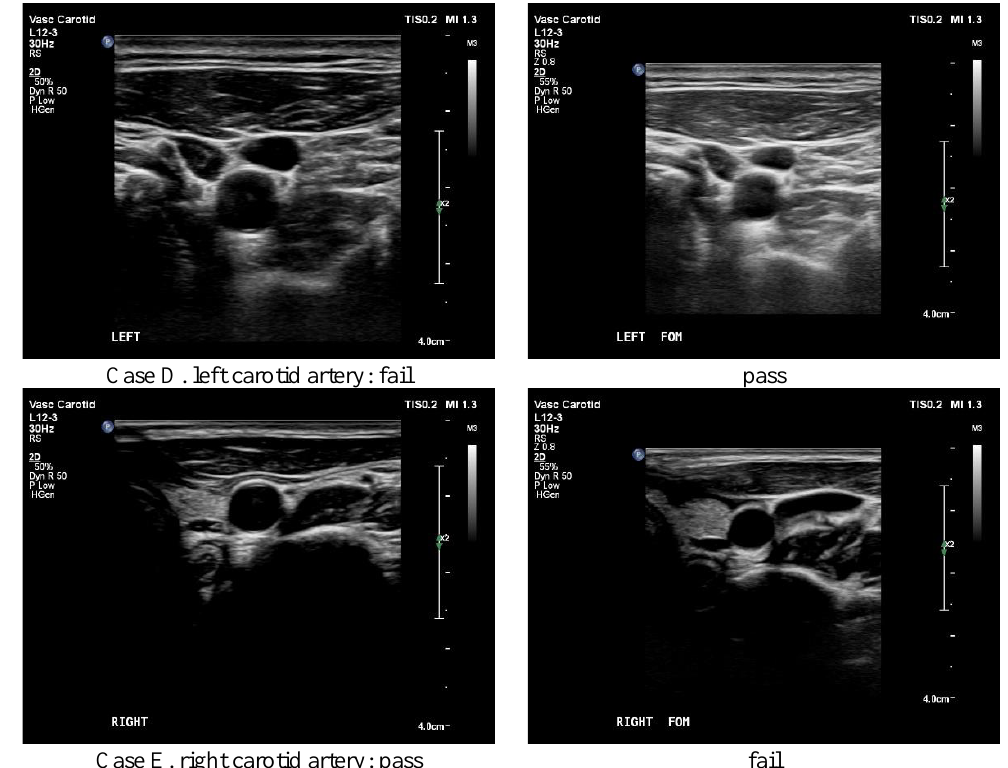
fail Figure 5. The ultrasound scanned images in this study. Pair ( A – D ) shows only one optimal pass, whereas pair ( E ) shows only one conventional pass that passed the clinical criteria. Table 5. Three well-trained radiologists graded the statistical data of 32 scanned images from 5 vol- unteers. Thus, a total of 192 (32 × 3 × 2 = 192) images were graded by three radiologists.